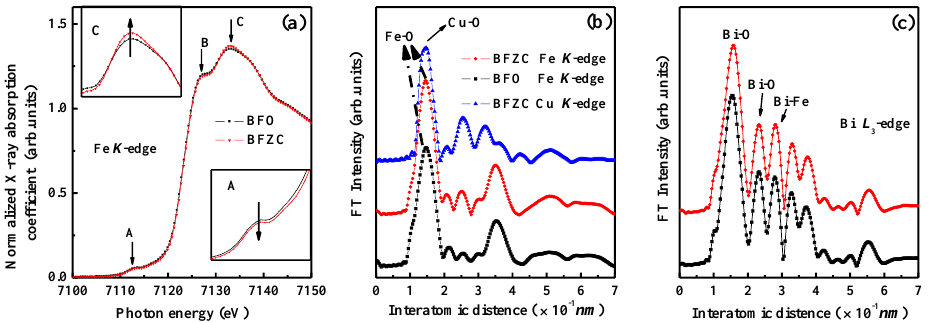
Figure 4. The XAFS data of the BFO and BFZC samples. ( a ) Fe- K XANES spectra. ( b ) Fourier transforms of BFO and BFZC obtained by Fe- K and Cu- K XAFS. ( c ) Fourier transforms of BFO and BFZC obtained by Bi- L 3 XAFS.